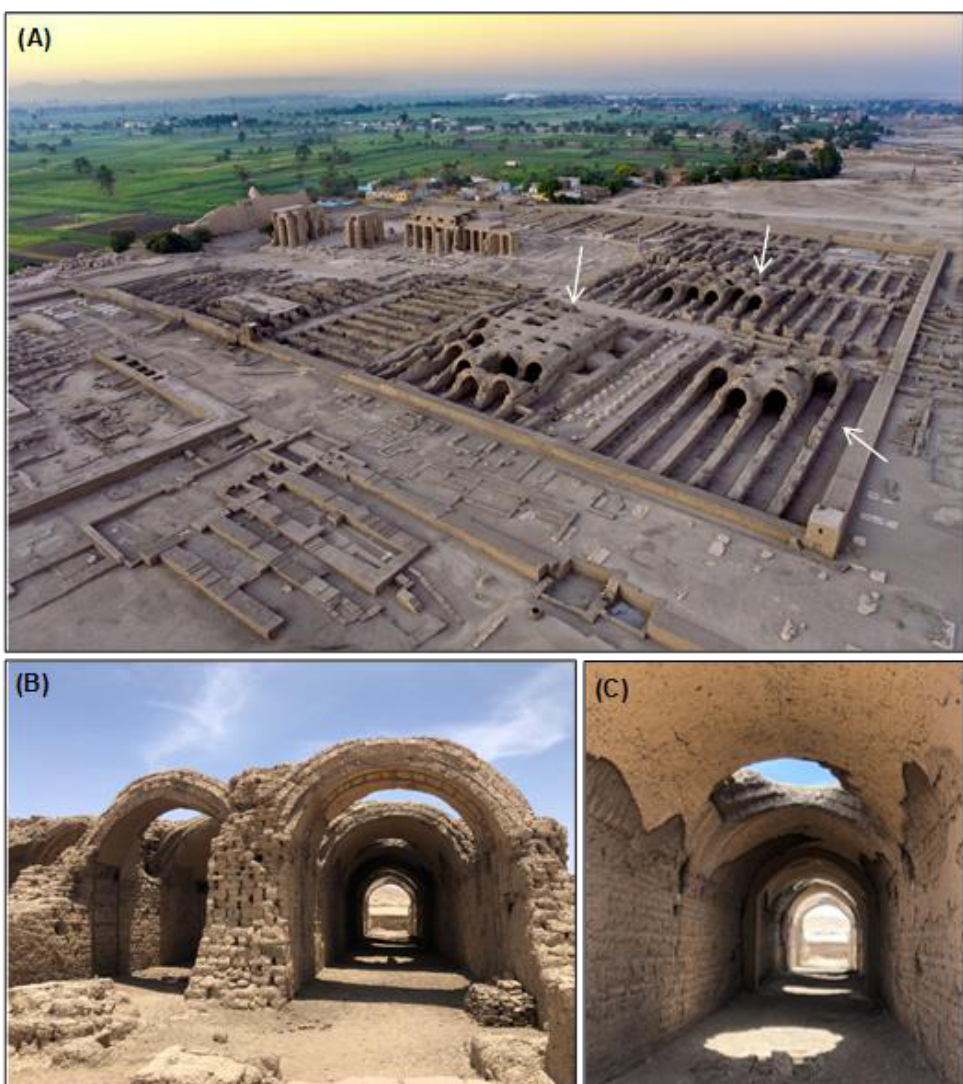
Figure 8. Aerial photo of the Ramesseum, the mortuary temple of King Ramesses II, which includes numerous mudbrick storerooms, pointed out with white arrows (source: Adobe Stock, WitR photos). The remotely sensed structures (Installations A – C ) at Hermopolis, shown in Figure 7, resemble these storerooms ( A ). Photos taken of exterior ( B ) and interior ( C ) of the mudbrick storerooms at the Ramesseum (photo taken by author).